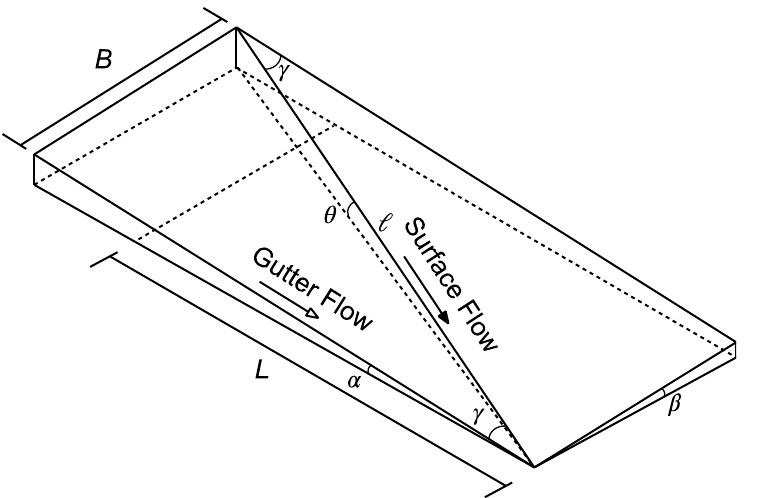
Figure 3. Schematic of the road surface flow calculation ( B : Road width, γ : Angle of the flow path, (cid:96) : Flow path length, θ : Flow slope, α : Longitudinal slope of the road, and β : Transverse slope of the road. In Figure 3, L is the road length between the upstream and downstream grate inlets, B is the road width, (cid:96) is the flow path length considering the road slope conditions, α is the longitudinal slope of the road, β is the transverse slope of the road, γ is the angle of the flow path, and θ is the flow slope. The angle of the flow path, flow slope, and flow path length are given by Equations (5)–(7), respectively.